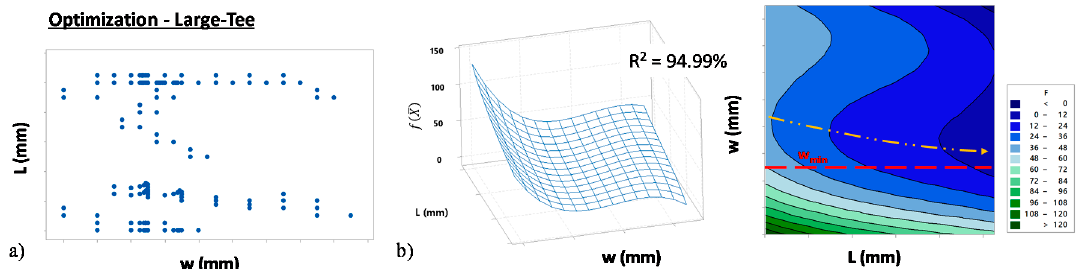
Figure 8. Results of the numerical optimization (Large-Tee). ( a ) Points tested by the algorithm in the (L, w) domain and ( b ) numerical fit of the objective function 𝑓(cid:4666)𝑋(cid:3364)(cid:4667) .